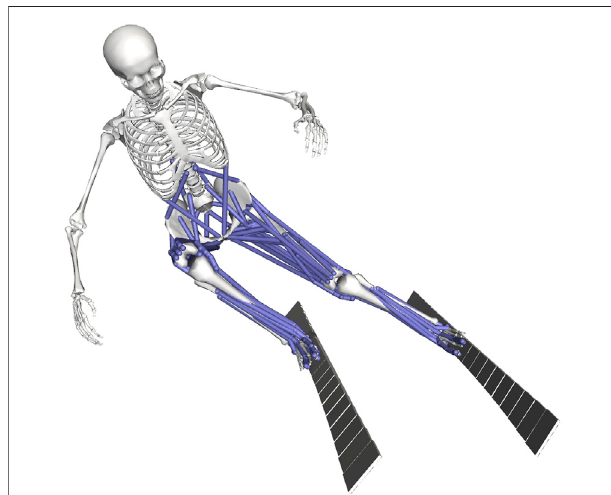
FIGURE 1 | Three dimensional musculoskeletal model of the skier with twoskis,53kinematicdegreesoffreedom(19fortheskierand17foreachski) and 94 muscles visualized in OpenSim (Delp et al., 2007). The subtalar and mtp joints were locked because of the skier ’ s ski boots, which allowed only plantar fl exion and dorsi fl exion at the ankle